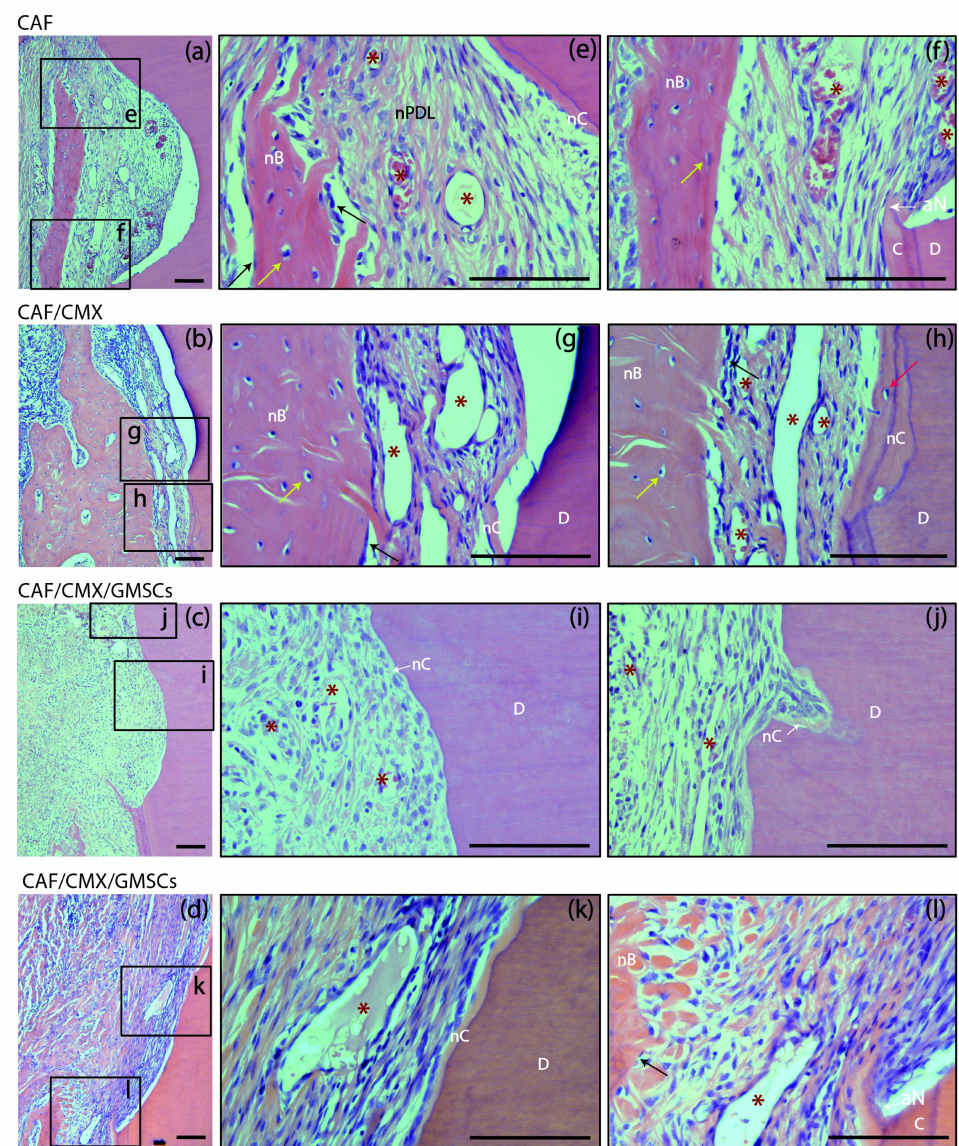
Figure 4. Bucco-lingual histological sections depicting the periodontal tissues at the level of the apical notch at 6 weeks; haematoxylin and eosin (HE) stain. ( a – d ) Images of the apical notch area in speci- mens from the four groups. ( e , f ) High-magnification images showing the newly formed cementum, bone and periodontal ligament in a specimen from the CAF group. ( g , h ) Images from a sample from the CAF+CMX group in which bone growth has extensively occurred despite the limited dimension of new cementum. ( i ) Newly formed connective tissue adhesion and cementum in a specimen from the GMSCs group. ( j ) New cementum formation in a resorption lacuna. ( k , l ) High-magnification pictures showing the histological attachment level gain associated with the newly formed cementum and the immature bone coronal to the apical aspect of the apical notch. CAF, coronally advanced flap; CAF+CMX, coronally advanced flap + collagen matrix; CAF+CMX+GMSCs, coronally advanced flap + collagen matrix + gingiva-derived mesenchymal stem cells; CAF+CMX+FBs, coronally advanced flap + collagen matrix + fibroblasts; SD, standard deviation; nB, new bone; nC, new cementum; nPDL, new periodontal ligament; C, cementum; D, dentin; aN, apical aspect of the apical notch; asterisks, blood vessels; black arrows, osteoblasts; yellow arrows, osteocytes; red arrow, cementoblast. Scale Bar = 100 µ